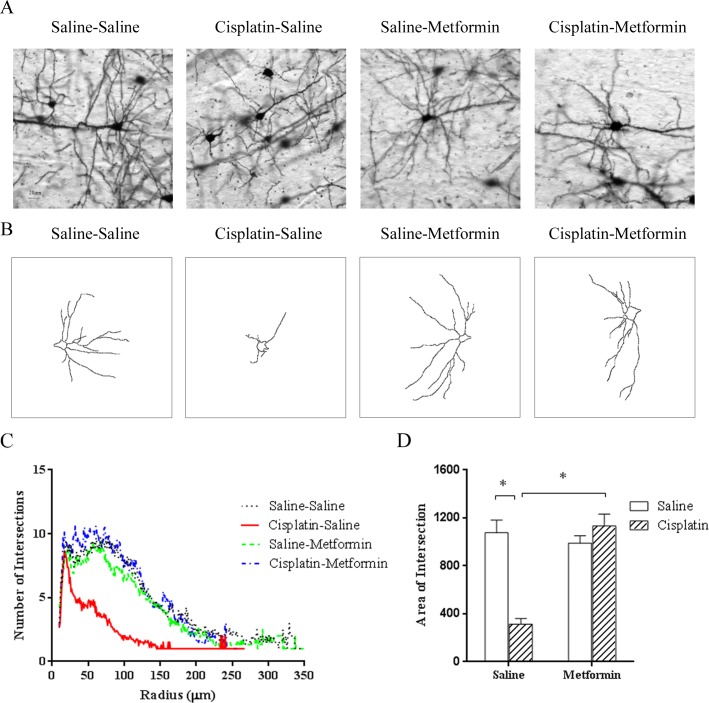
Effect of cisplatin and metformin on dendritic branching.Sholl-analysis of pyramidal cells in the cingulate cortex of Golgi-stained brains was performed. (A) Examples of actual and (B) reconstructed pyramidal cells. (C) Plot of intersection number vs radius. (D) Areas under the curve of plots in (C) were analyzed Two-way ANOVA (cisplatin×metformin, F(1,31) = 34.81, p<0.05) followed by LSD. Scale bar: 20μm. All data are expressed as mean±SEM. *, p<0.05. n = 8–11 per group.